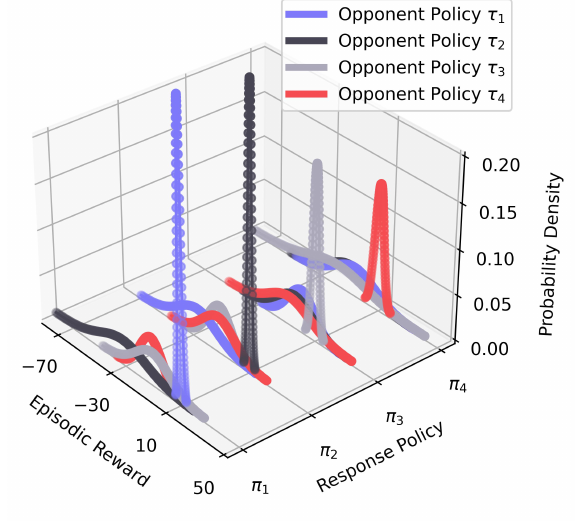
Figure 5. The performance model P .